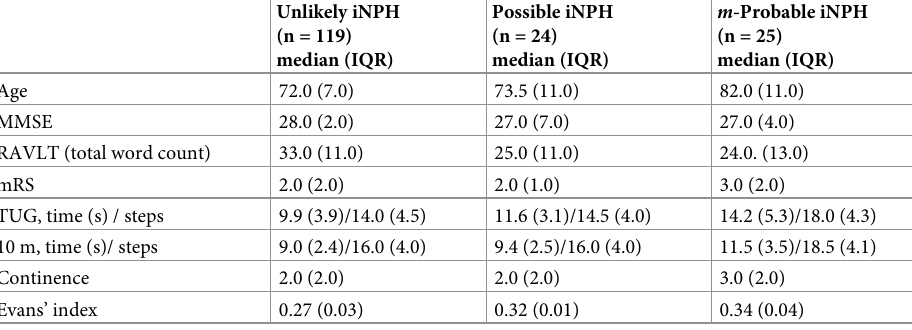
Table 3. Characteristics of the study sample (n = 168), broken down into diagnosis (American-European guidelines).